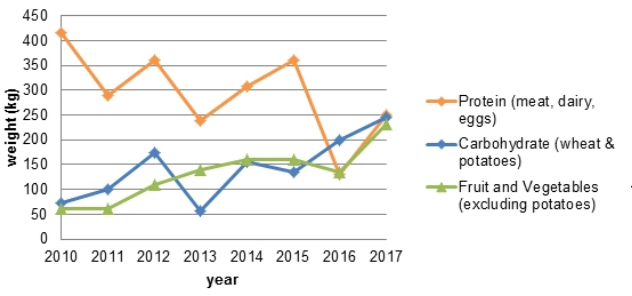
Figure 2. Production trends: annual output by food cate- gory, 2010–2017 (kg).